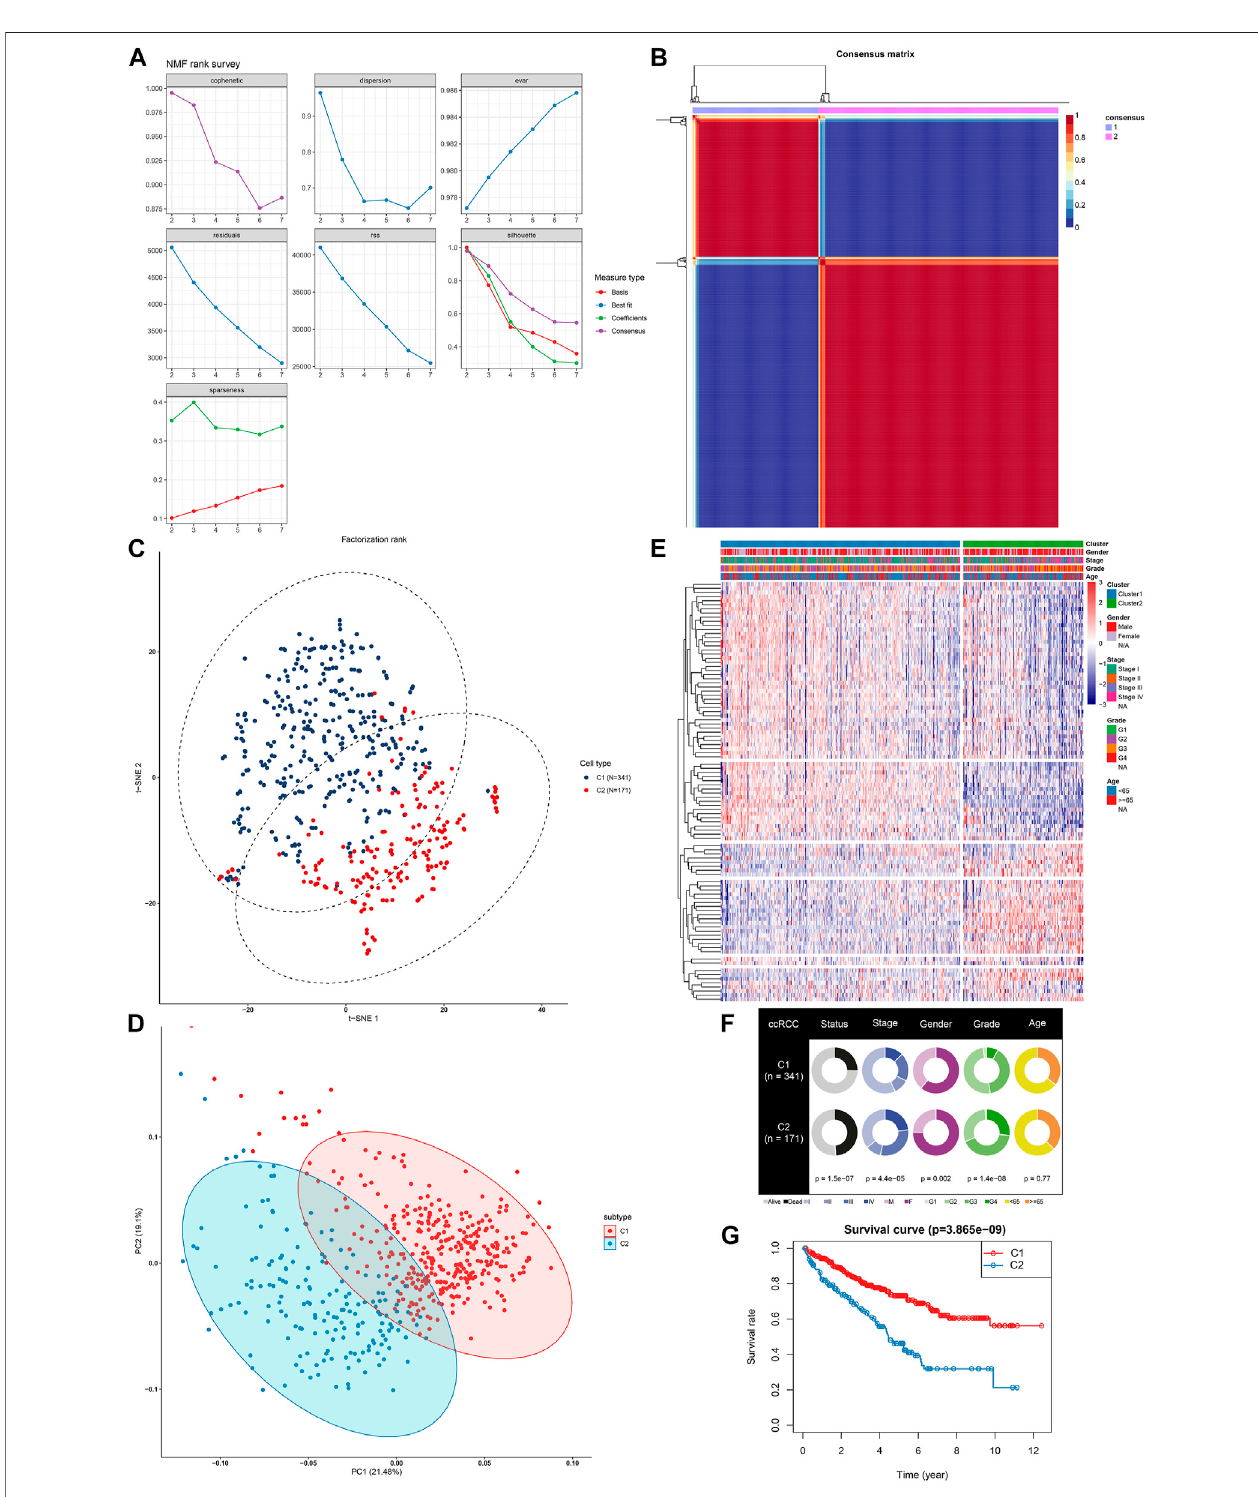
FIGURE1| NMFidenti fi estwodistincthypoxia-relatedmolecularsubtypesforccRCCinTCGA-ccRCCdataset (A) Factorizationrankfork (cid:1) 2 – 7 (B) Theheatmap of the consensus matrix when the consensus clustering k (cid:1) 2. The value range is0 – 1. The columns and rows are sorted through hierarchical clustering according to the Euclideandistanceoftheaveragelink (C) ThePCAand (D) t-SNEscatterplotsareinsupportoftheclassi fi cationintotwoccRCCmolecularsubtypesbasedonthegene expression pro fi les. The colors are indicative of samples from two molecular subtypes (E) The heatmap visualizing the expression patterns of hypoxia genes in the two subtypes. Samples are clustered according to different clinical features (F) Correlation between subtypes and clinical features (G) Kaplan-Meier OS curves for the two clusters in TCGA-ccRCC dataset. The assessment of difference was achieved by log-rank test.